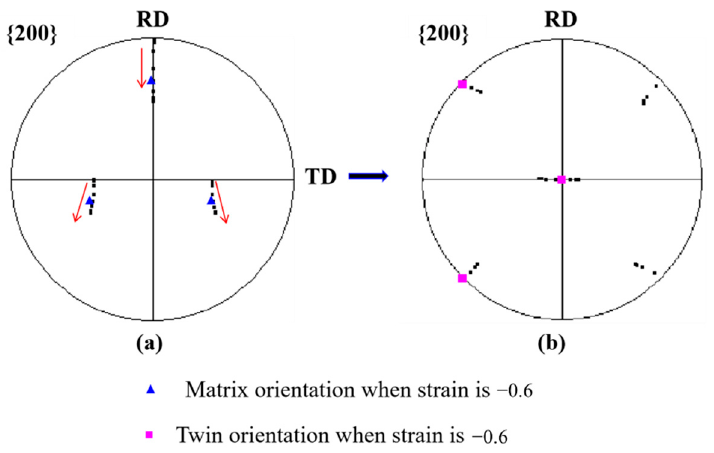
Figure 6. The orientation rotation path of Goss orientation: ( a ) corresponding twinning orientation; ( b ) during cold rolling, strain value = − 0.6.